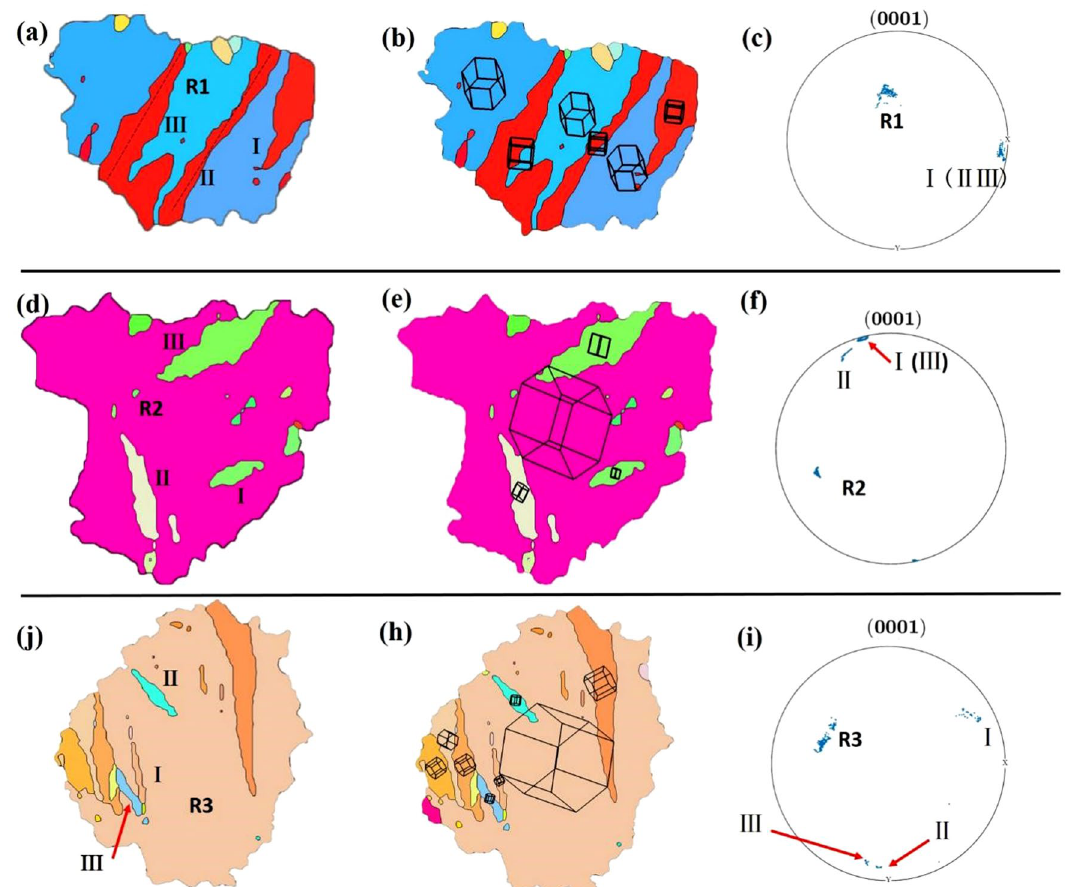
Figure 9. Selected grain area in ultra-low temperature rolling deformation Mg–2Y–0.6Nd–0.6Zr alloy. ( a ), ( d ), ( j ) Inverse pole figure maps, ( b ), ( e ), ( h ) three-dimensional stereoscopic orientation diagrams of individual grains, and their twins are shown in the (0001) pole figures in ( c ), ( f ), ( i ).